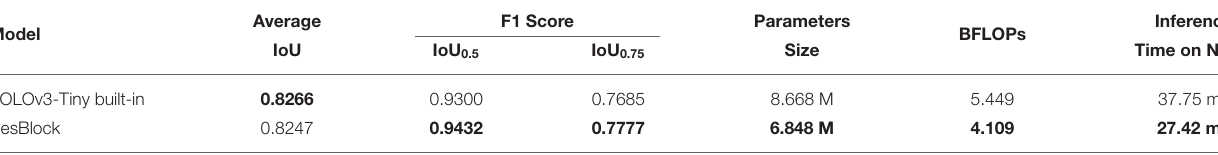
TABLE 3 | Accuracy improvement by ResBlock.